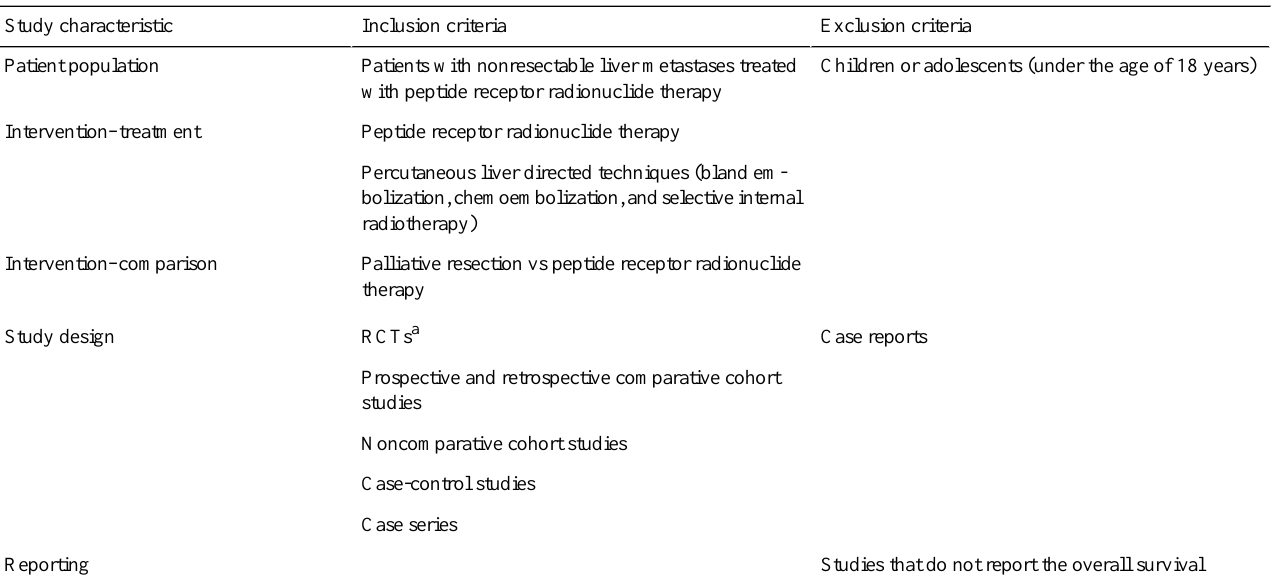
Table 3. Eligibility criteria for review 3: when should peptide receptor radionuclide therapy be performed in patients with nonresectable neuroendocrine liver